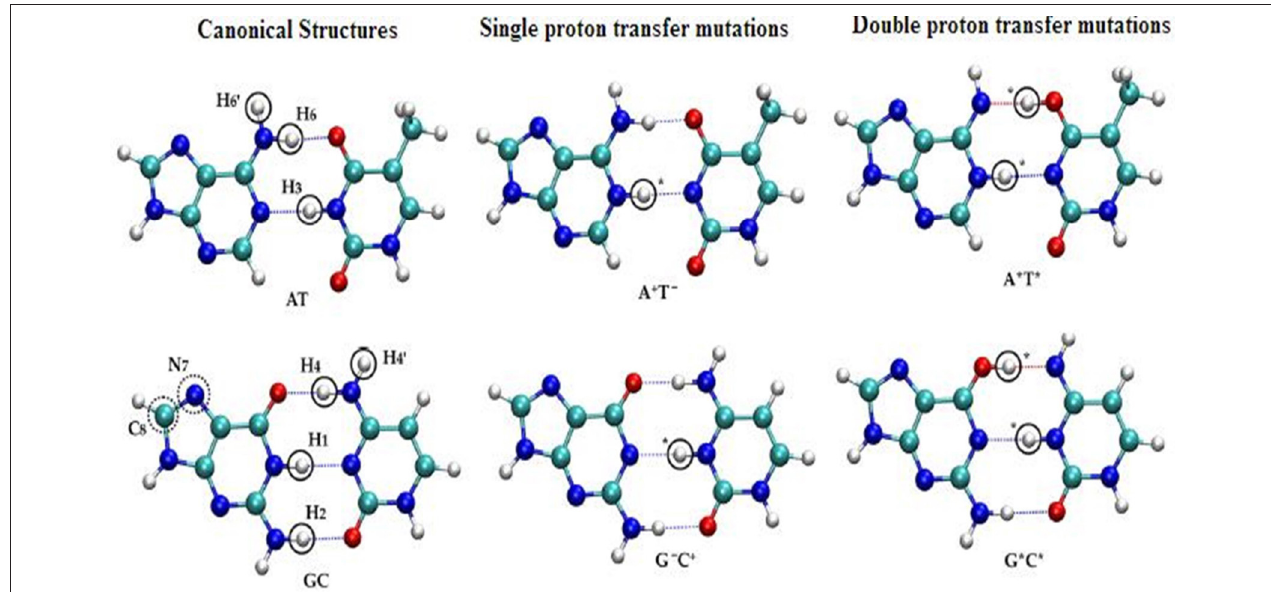
FIGURE 8 | Structural representation of the single and double proton transfer mechanisms of canonical (AT, GC)